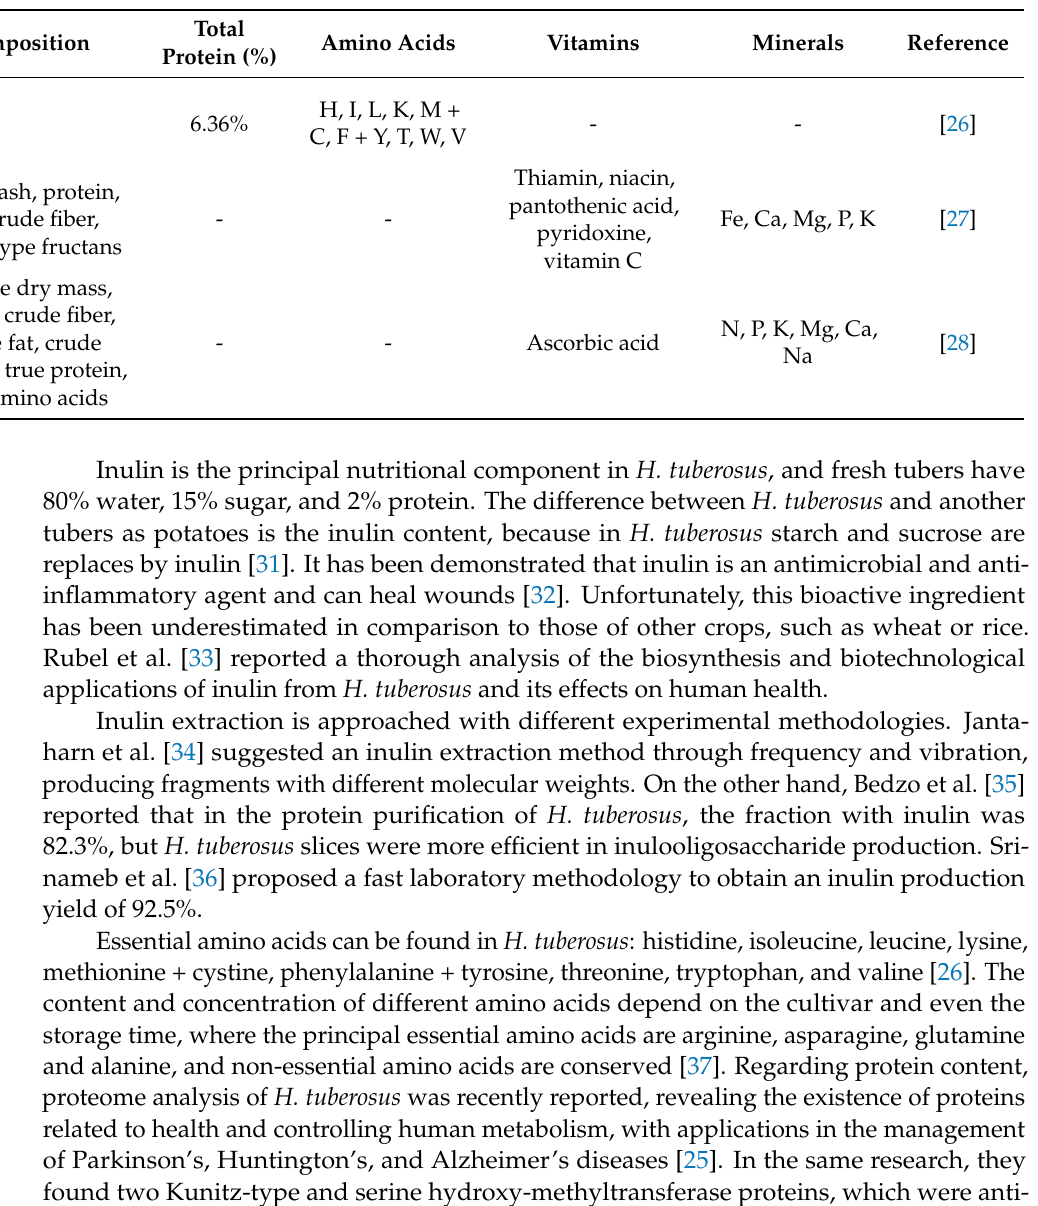
Table 2. Principal components with nutritional value found in H. tuberosus